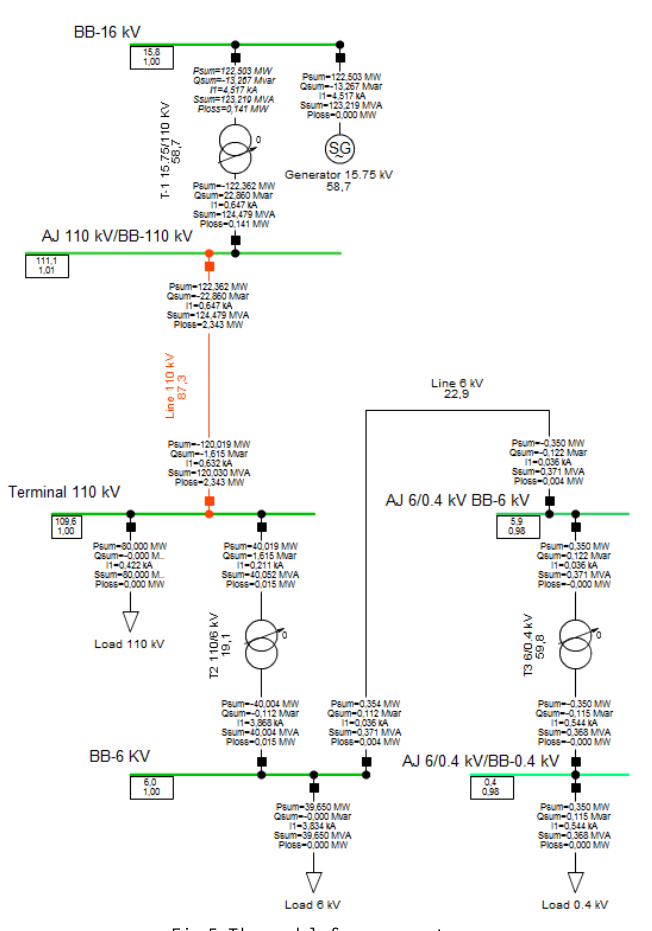
Fig. 5. The model of a power